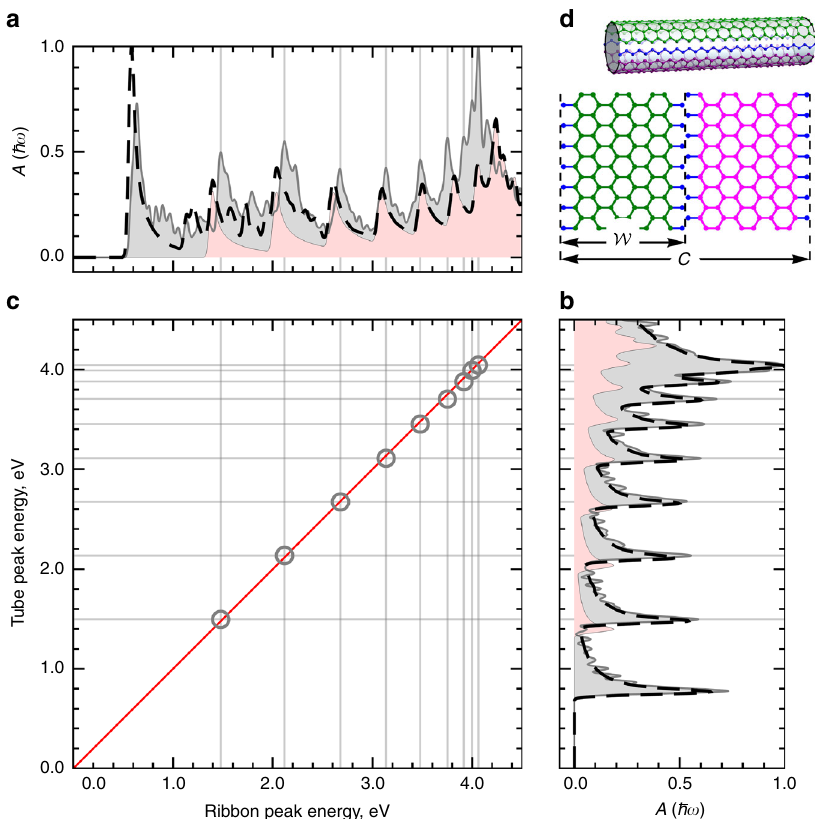
Fig. 4 2 N þ 4 -rule for optical resonance alignment. The optical absorption of a ZGNR ð 20 Þ and b SWCNT ð 21 ; 21 Þ in the DFT (light gray fi lled) and fi tted TBM (black dashed). The light red fi lling in both a and b panels represents the bulk optical absorption of ZGNR ð 20 Þ obtained in the fi tted TBM. c Two- dimensional energy plot of the ZGNR ð 20 Þ and SWCNT ð 21 ; 21 Þ resonances. Thin gray grid lines in a , b , and c mark the positions of the interband optical resonances extracted from the DFT optical spectra. Gray circles in c denote the intersections of the grid lines of most aligned resonance peak energy pairs ð E ribbon ; E tube Þ . The red solid line represents a perfect resonance alignment E tube ¼ E ribbon used as a reference. d Decomposition of SWCNT ð 7 ; 7 Þ with circumference C into two ZGNR ð 6 Þ (magenta and green) with effective width W , which accounts for the two zigzag chains of carbon atoms (blue) to be ffiffiffi ffiffiffi p p a = 2, where W ¼ aw = 2 is the ribbon width and a is the graphene lattice constant. If n ¼ w þ 1 then removed. The effective ribbon width W ¼ W þ 3 3 C = 2 ¼ W which is equivalent to N 2 N þ 4, where N and N are the number of atoms in the unit cell of the tube and ribbon, respectively. This t ¼ t decomposition also connects SWCNT ð 21 ; 21 Þ with ZGNR ð 20 Þ